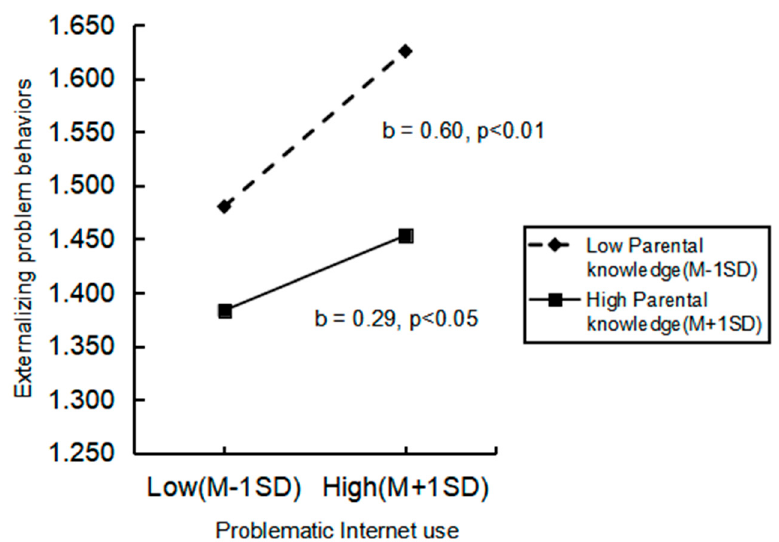
Figure 2. Simple slope analyses of the moderating effect of parental knowledge.